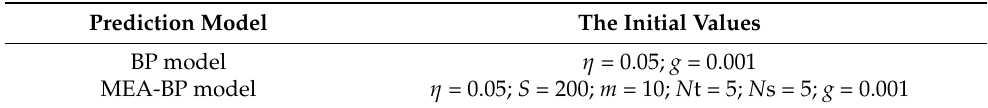
Table 5. Parameters of two prediction models.